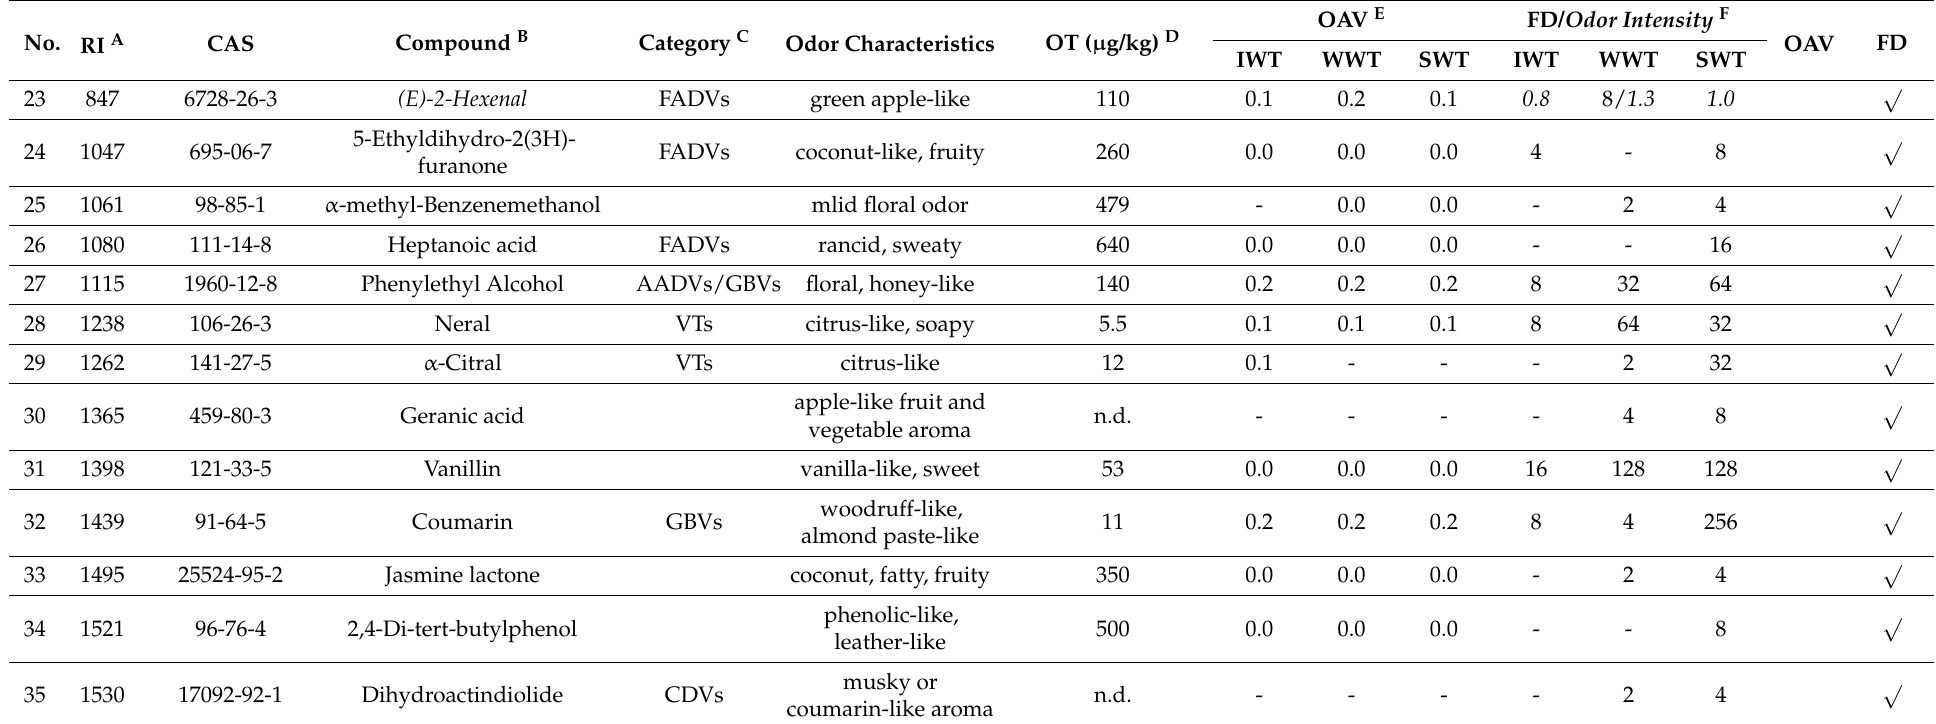
GBVs, glycosidically bound volatiles. D : Odor thresholds in water are in reference to the literature ([12,23–25]). E : Odor activity value, the ratio of the concentration of an odor-active compound to its odor threshold value. F : Flavor dilution factor and odor intensity were evaluated by AEDA and GC–O. “-” indicates FD factor < 4 (IWT, indoor withering-treated white tea; WWT, withering-tank withering-treated white tea; SWT, sunlight withering-treated white tea; n.d., not